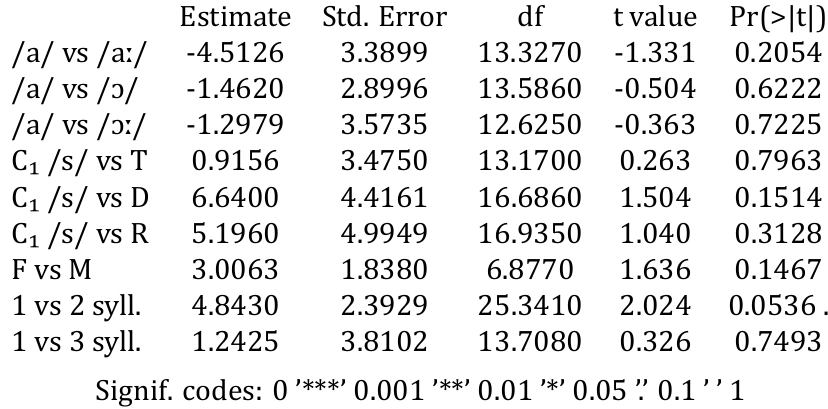
Table A.20: Breathiness occurrence prior to C₂ fortis plosive as a de- pendent